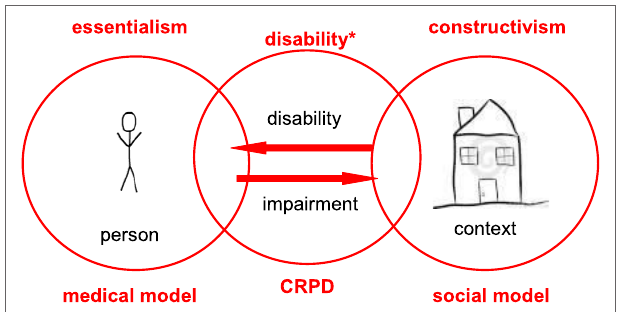
FigUre 1 | the locus of disability varies: whereas the medical model primarily holds individual impairments’ responsible, the social model of disability rather focuses on contextual constraints . The Convention on the Rights of Persons with Disabilities (CRPD) combines both models in taking into account both a person’s impairments and factors in his or her environment that only in relation hinder their participation in